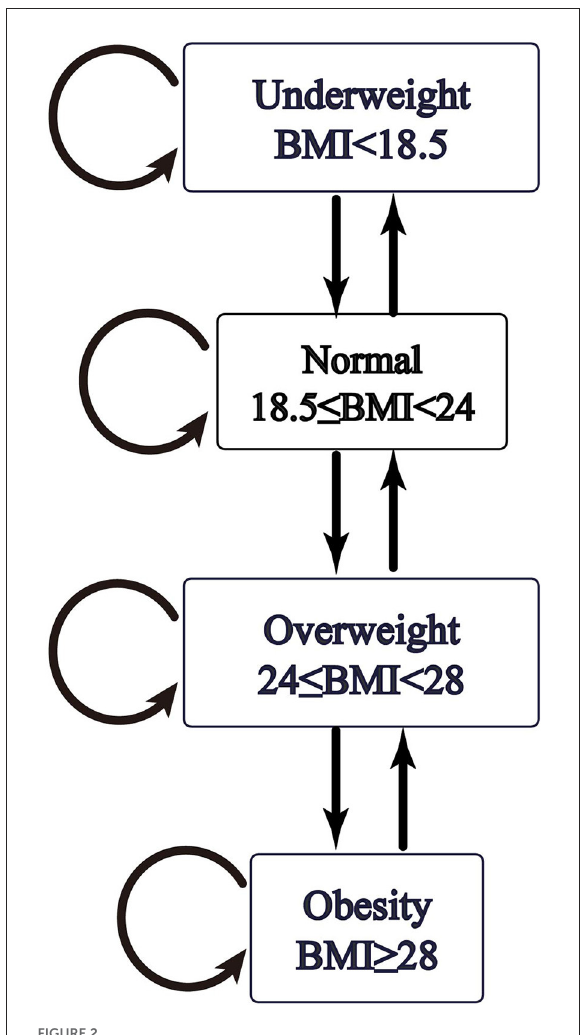
FIGURE2 Hypothesized transition diagram of Markov process based on BMI status